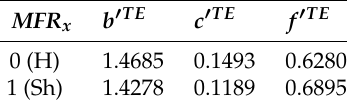
Figure 17. Twin-entry/dual-volute radial turbines expansion process in partial admission conditions. Table 4. Fitting coefficients of partial admission conditions using apparent